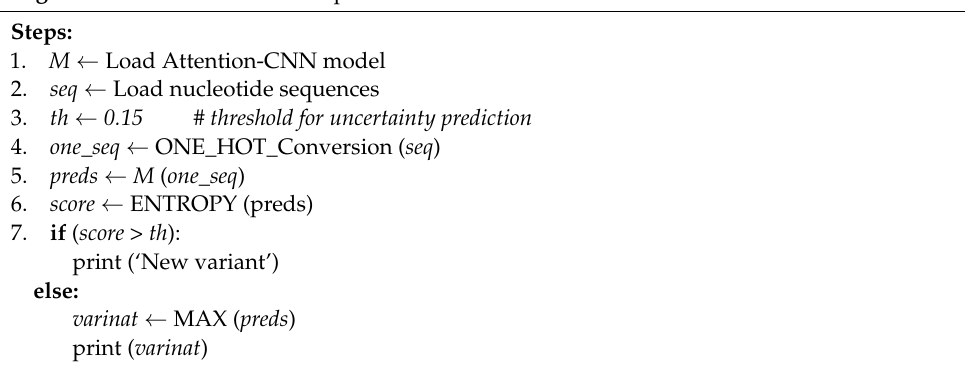
Algorithm 1: COVID-19 variant